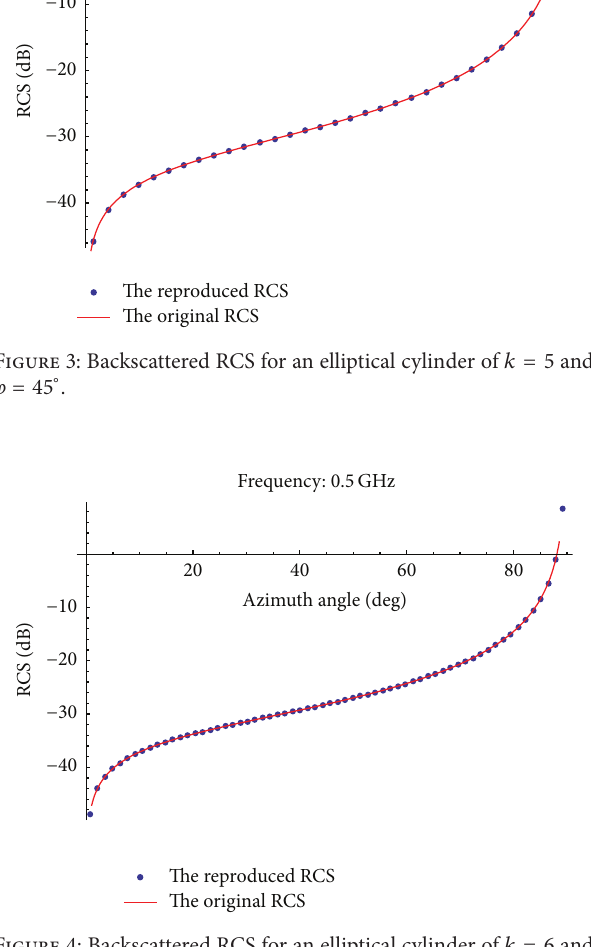
Figure 4: Backscattered RCS for an elliptical cylinder of 𝑘 = 6 and 𝜑 = 45 ∘ .